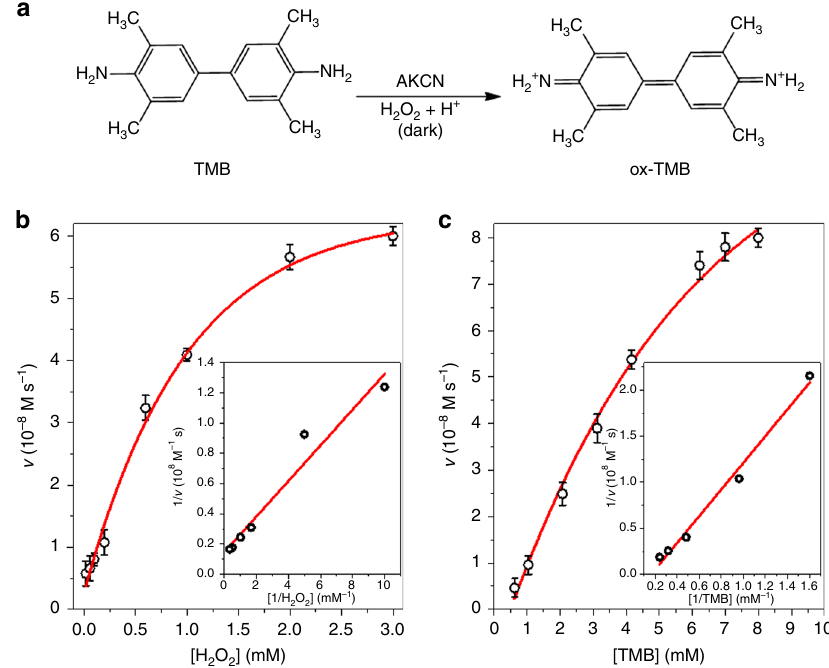
Fig. 6 Steady-state kinetics for the peroxidase mimicking dark-reaction of AKCN. a Scheme of the peroxidase-like reaction. The reaction rate as a function of b [H 2 O 2 ] and c [TMB] in the acetate buffer (0.1 M, pH 4) suspension of AKCN (0.5g L − 1 ) with TMB and H 2 O 2 for 10min incubation. Inset: Lineweaver – Burk plots. The error bar represents the standard deviation from the repeated experiment after three times. Source data are provided as a Source Data fi